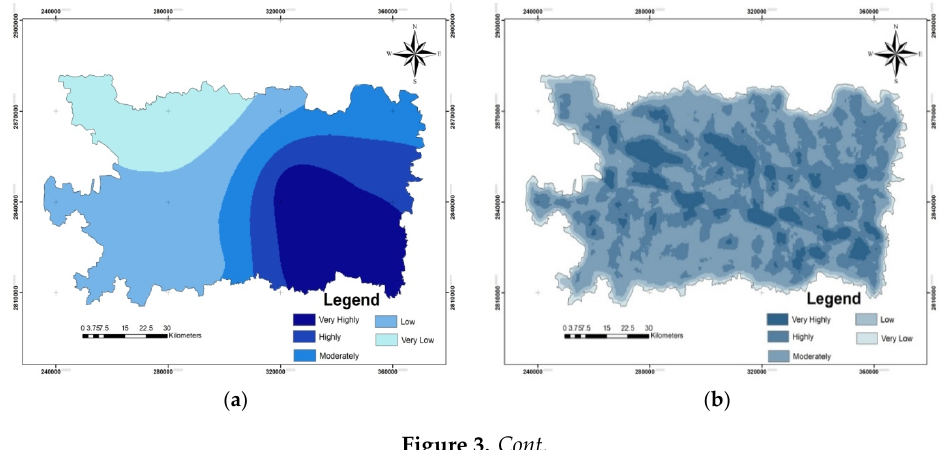
Table 4. Pair-wise comparison matrix, and final weights ( w i ) for flood susceptibility